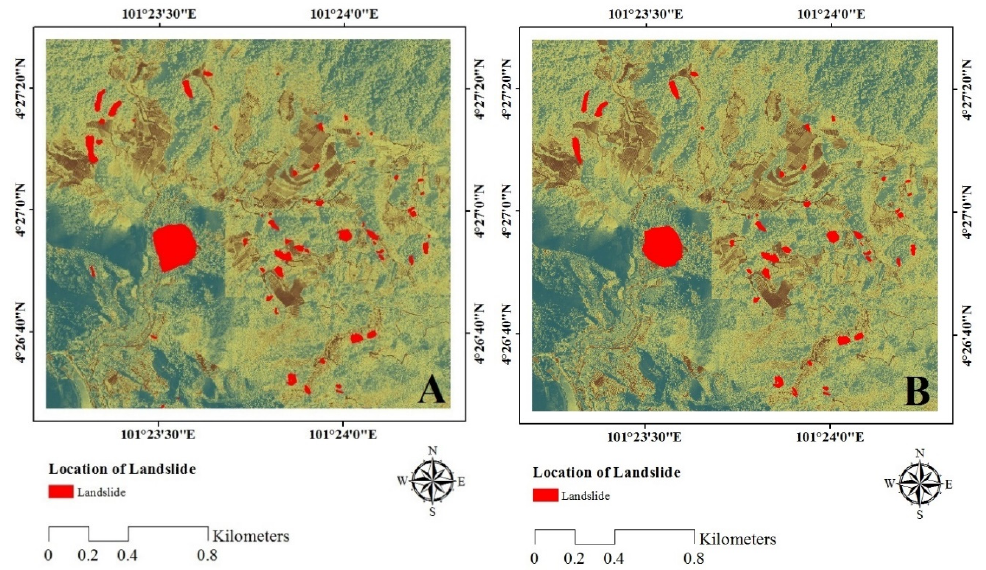
Figure 10. Results of the qualitative assessment of ( A ) RNN and ( B ) MLP ‐ NN for the test area.